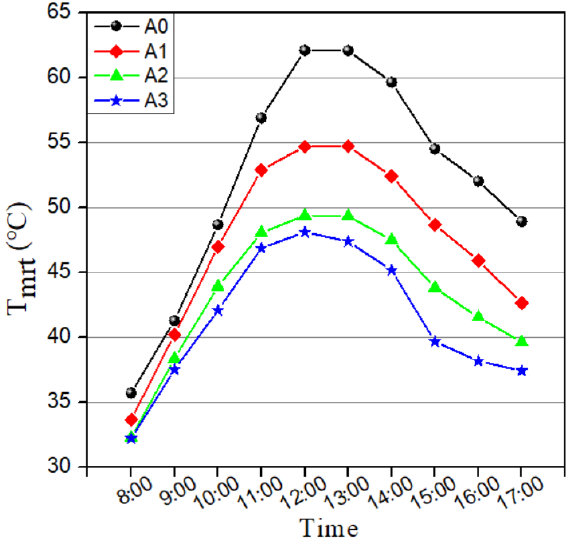
Figure 11. T mrt of the base case and cases with different greening rates.